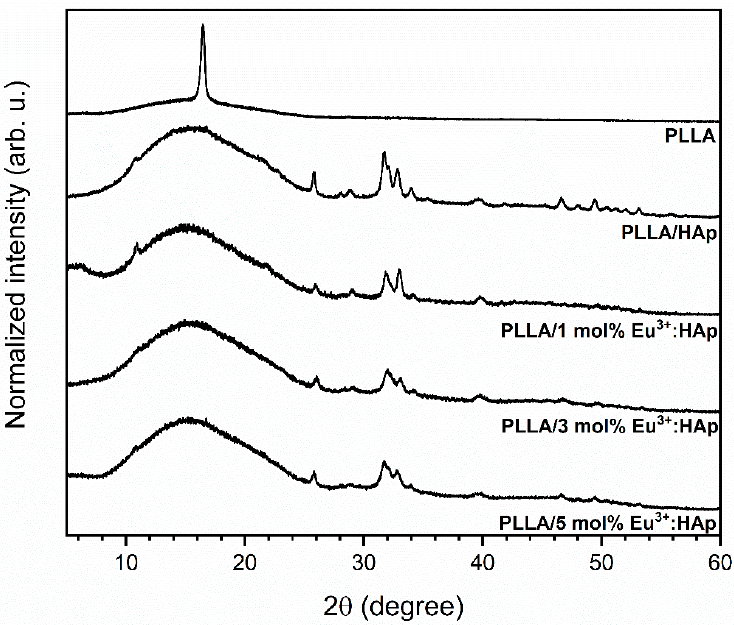
Figure 3. X-ray di ff raction patterns of PLLA / x mol% Eu 3 + :HAp composites (where x = 0–5) obtained with the extrusion method.